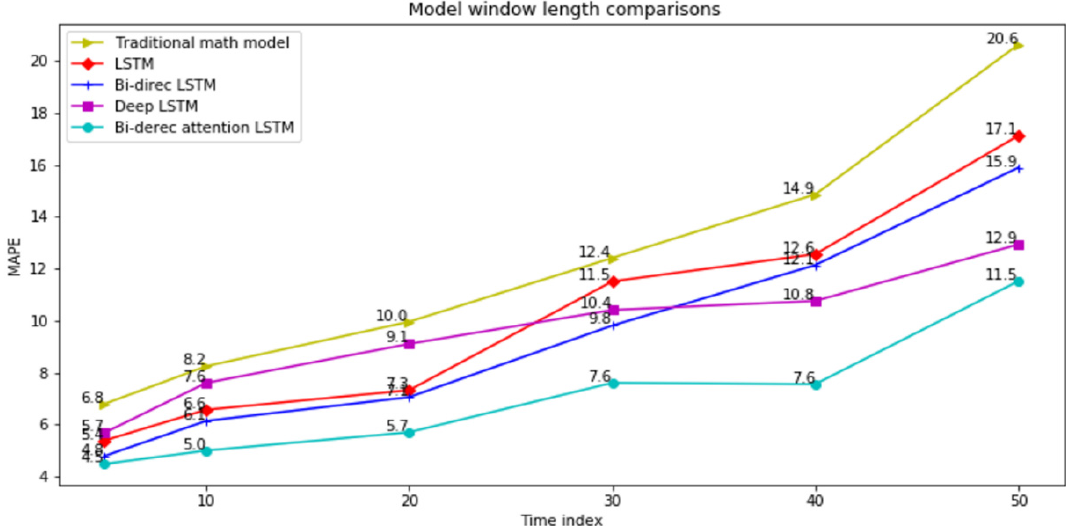
Figure 19. Model comparisons with different time window lengths.